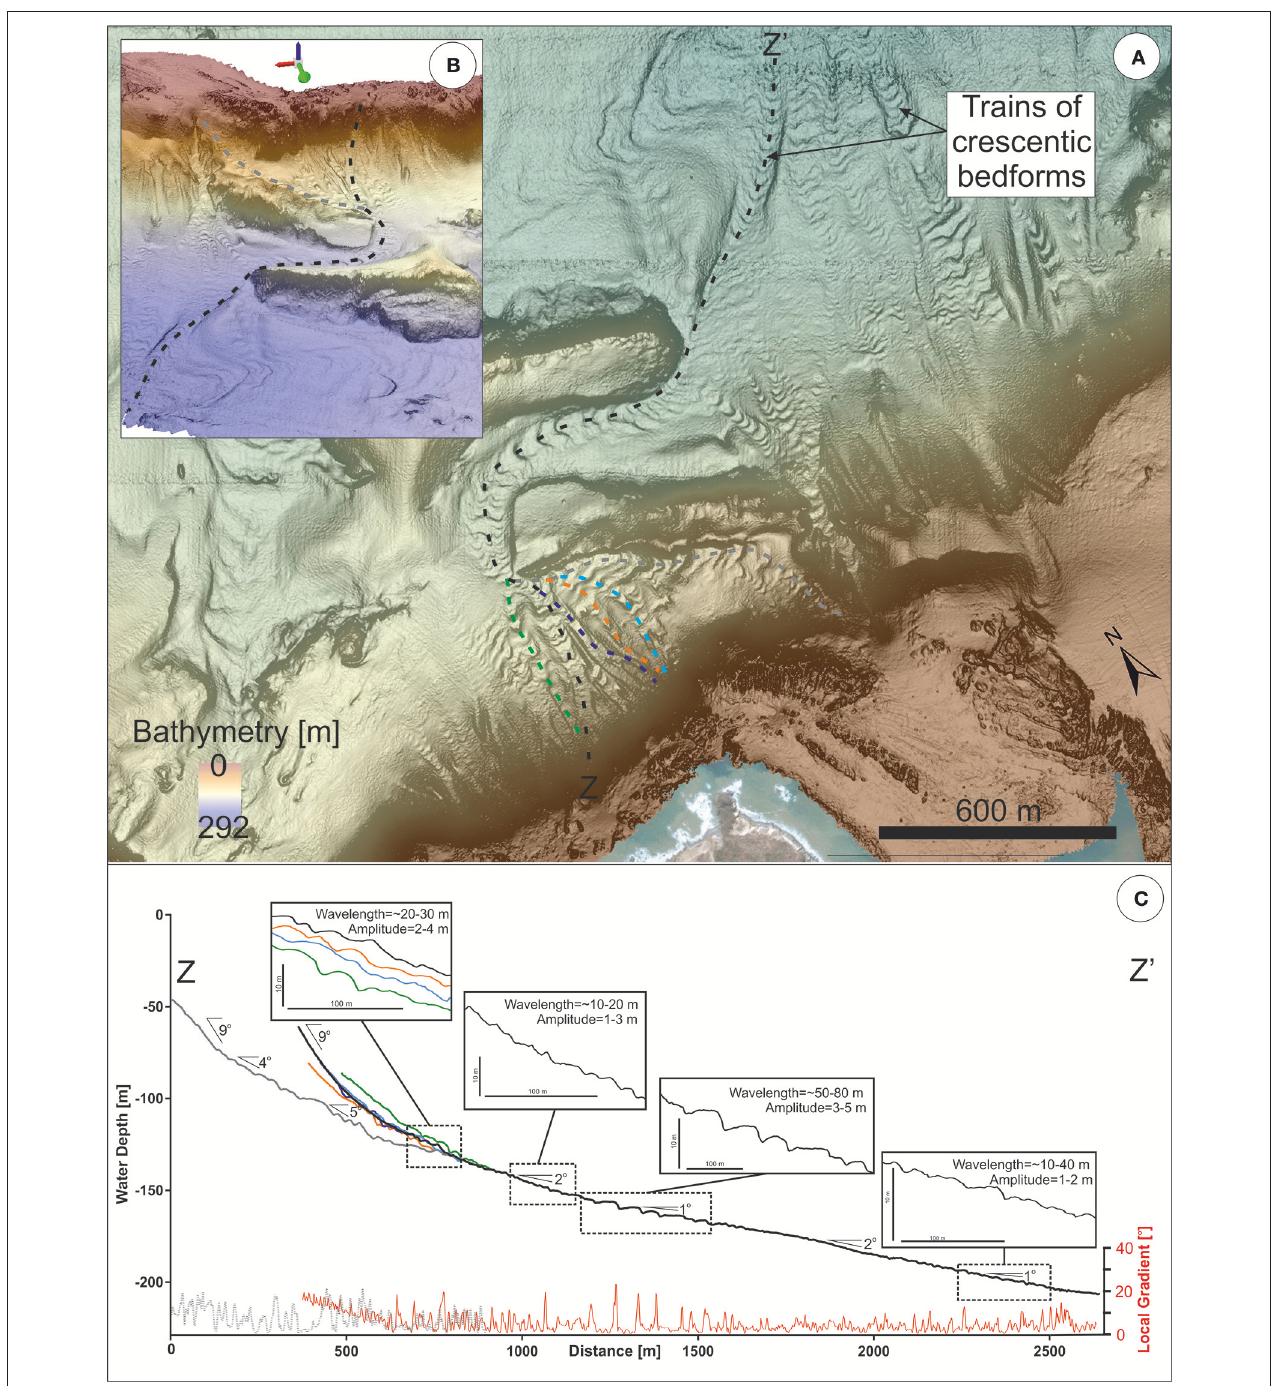
FIGURE 5 | Overview map (A) and 3D rendering (B) annotated with dashed lines along the axis of sinuous coalescent channels with cresentic bedforms that originate ∼ 2.5km to the east of Sulfur Bay. Along-channel profiles (black, gray, blue, orange and green lines in C) show how bedforms generally increase in wavelength and amplitude to 1,500m water depth, but then decrease in response to the constriction of the channel. Average slope gradients are annotated on the black profile, while local slope gradient that highlights bedforms is shown as a red line in (C) .